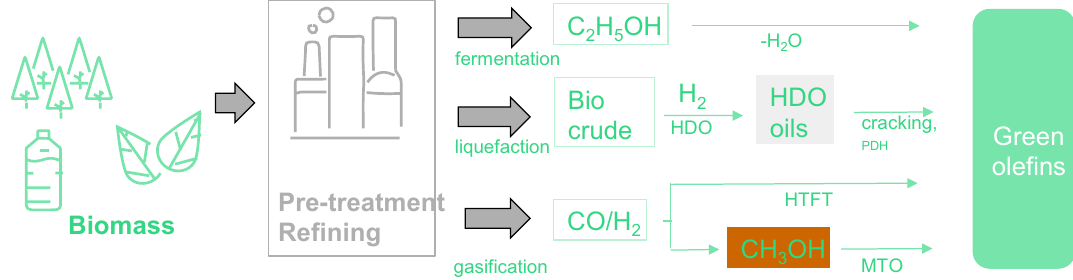
Fig. 3 Main conversion pathways in biomass-to-olefins (green)